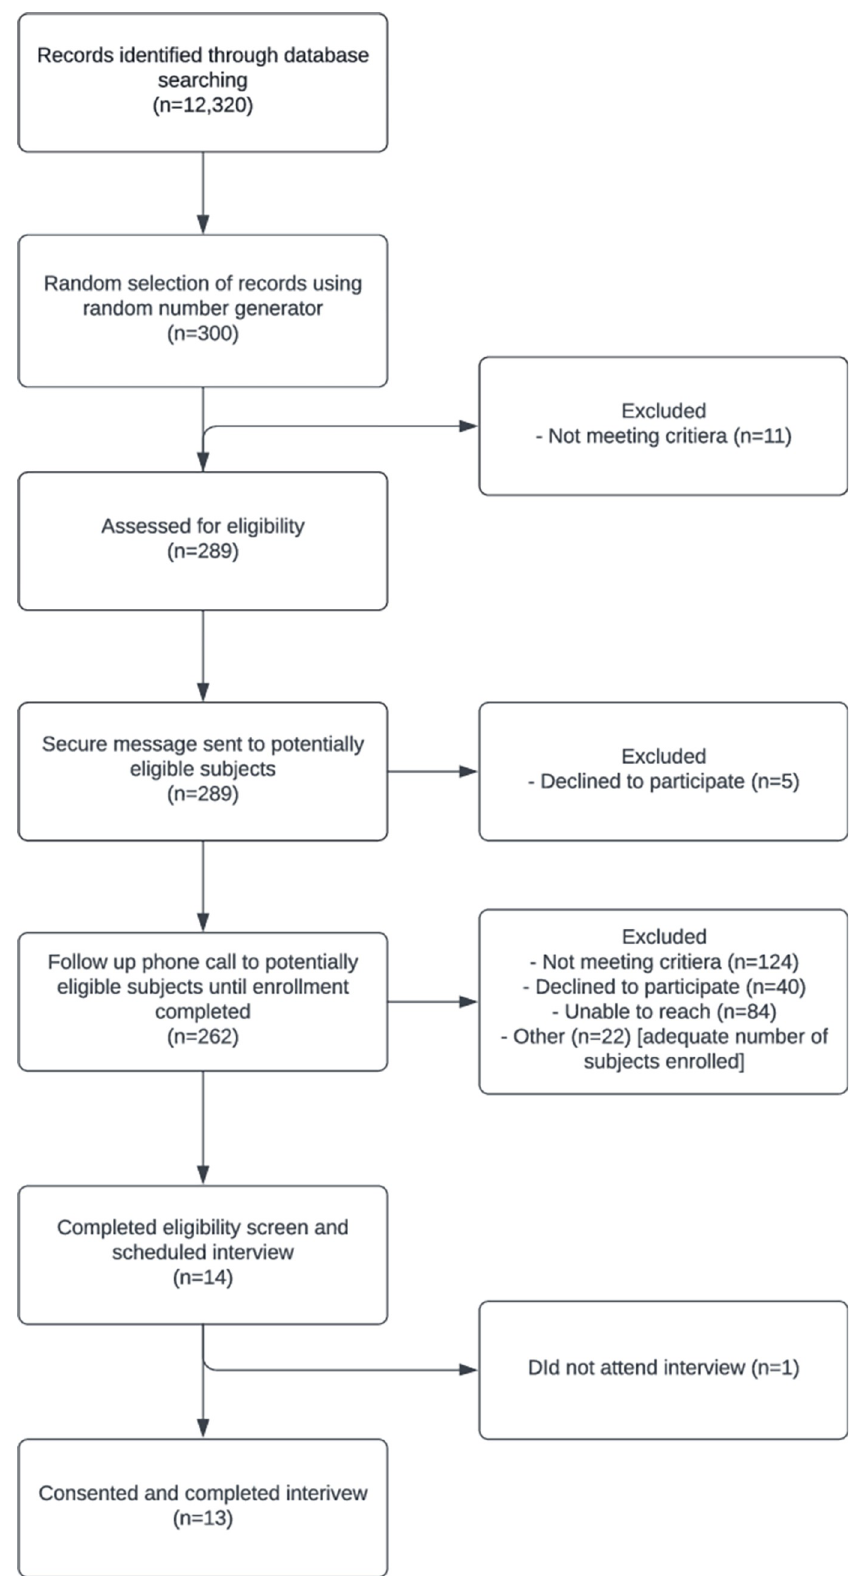
Fig 1. CONSORT diagram: Eligibility screening and